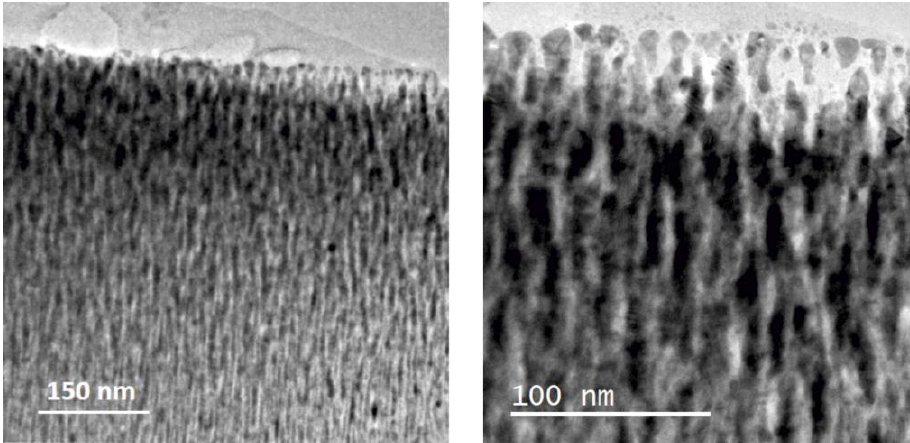
Figure 4. Cross-sectional TEM images of the 65C sample.